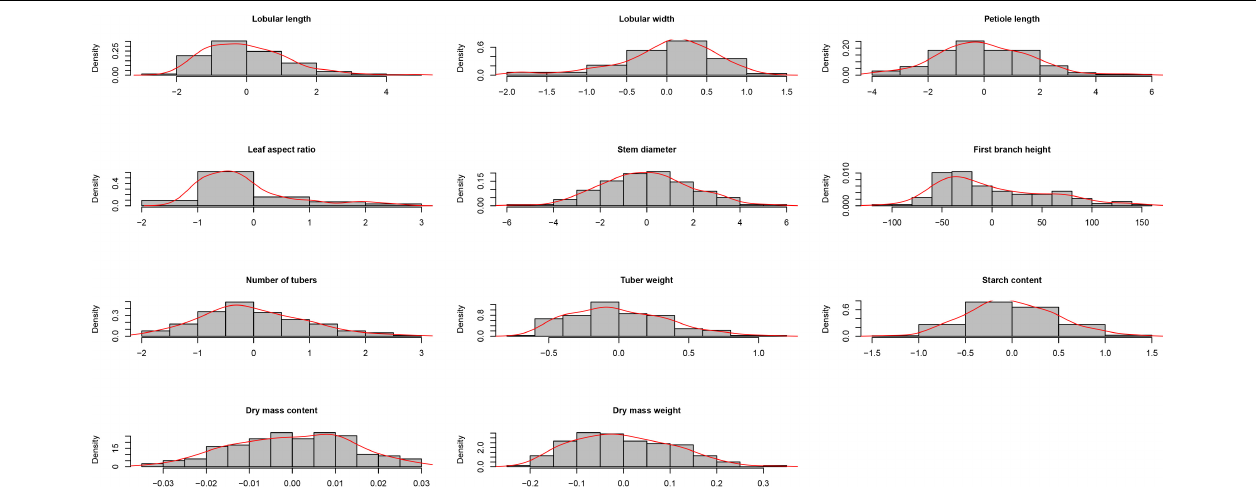
FIGURE 4 | Density distribution of variation in 11 traits (best linear unbiased prediction values) in cassava